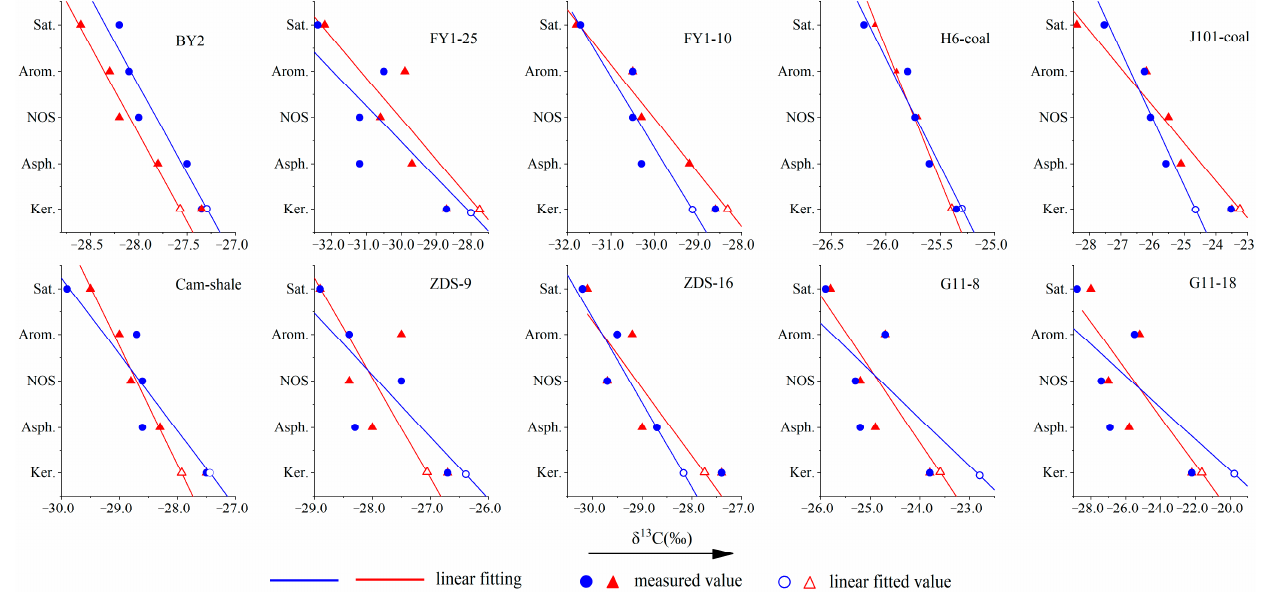
Figure 4. Stable carbon isotopic type-curves (red and blue indicate that the samples were extracted with DCM: MeOH (9:1/v: v) and TCM, respectively).